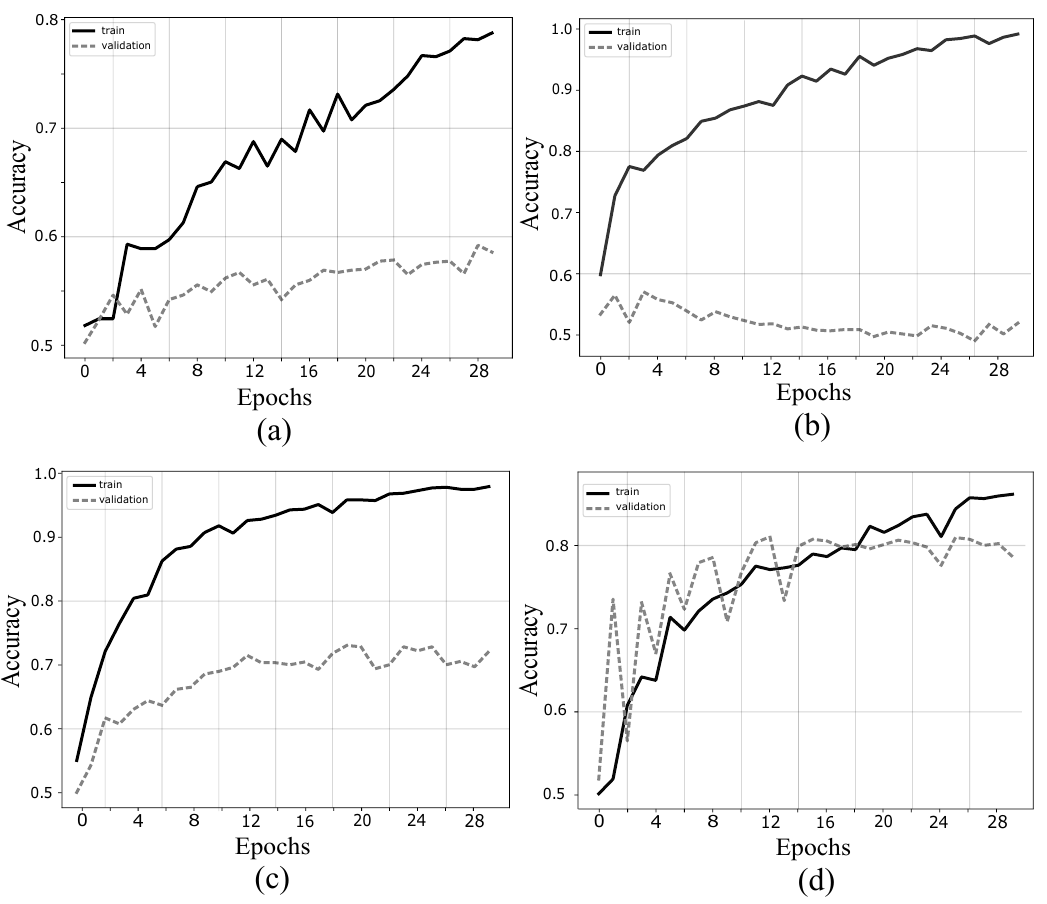
Figure 5. Train and test validation behaviour for subject aa in cases. ( a ) without BSS; ( b ) with no sorted fastICA; ( c ) with sorted SOBIRO; and ( d ) with sorted fastICA (30 epochs). with the sorted HOS fastICA, both the training data and the validation data achieve values higher than 0.8, reducing the phenomenon of overfitting in comparison to the other